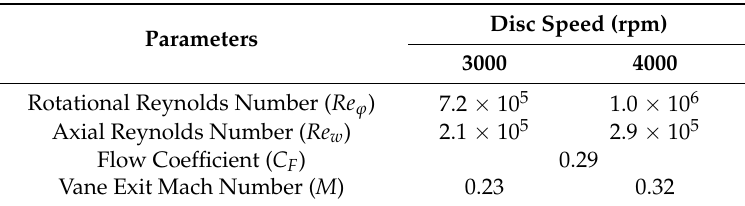
Table 1. Test rig operating